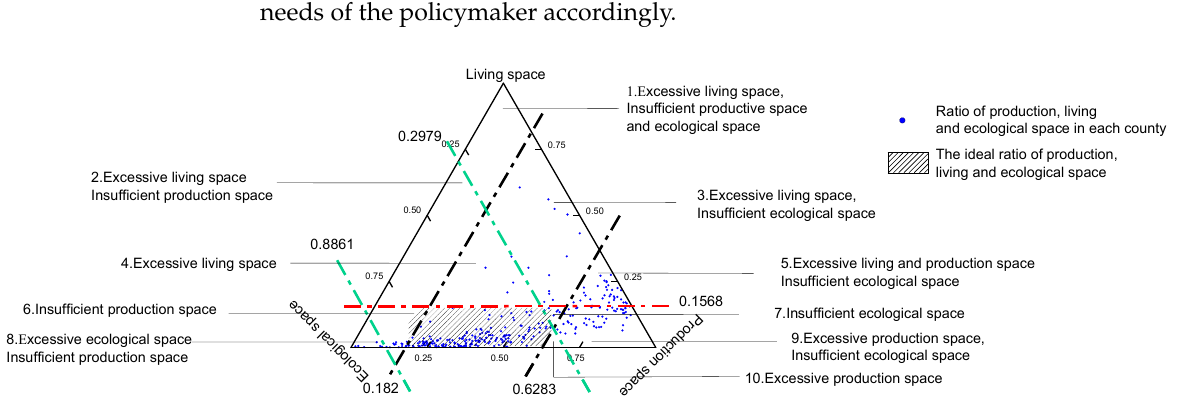
Figure 7. Ternary phase diagram of production-living-ecological space.